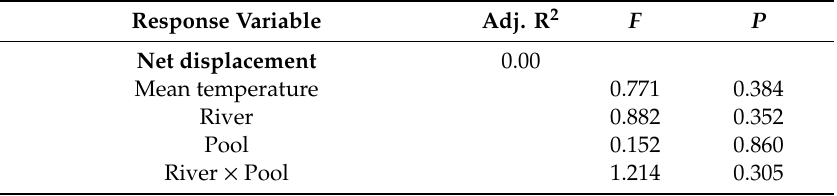
Table 2. Output of the linear models for each of the four response